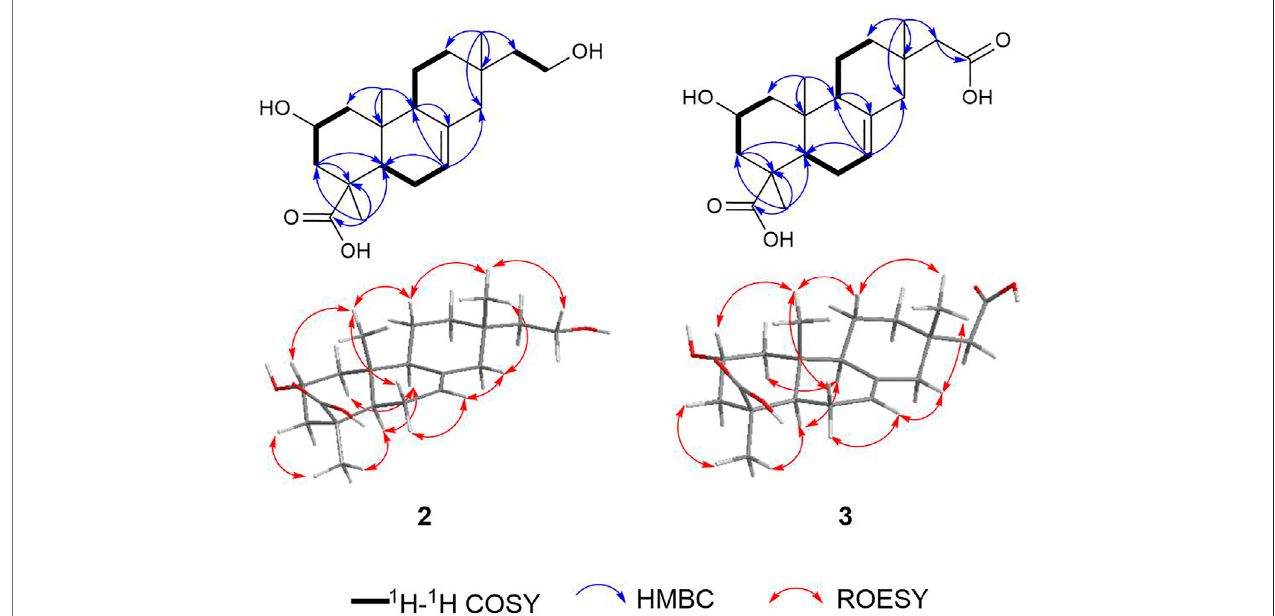
FIGURE 4 | Key 2D NMR correlations of compound 2 and 3 .